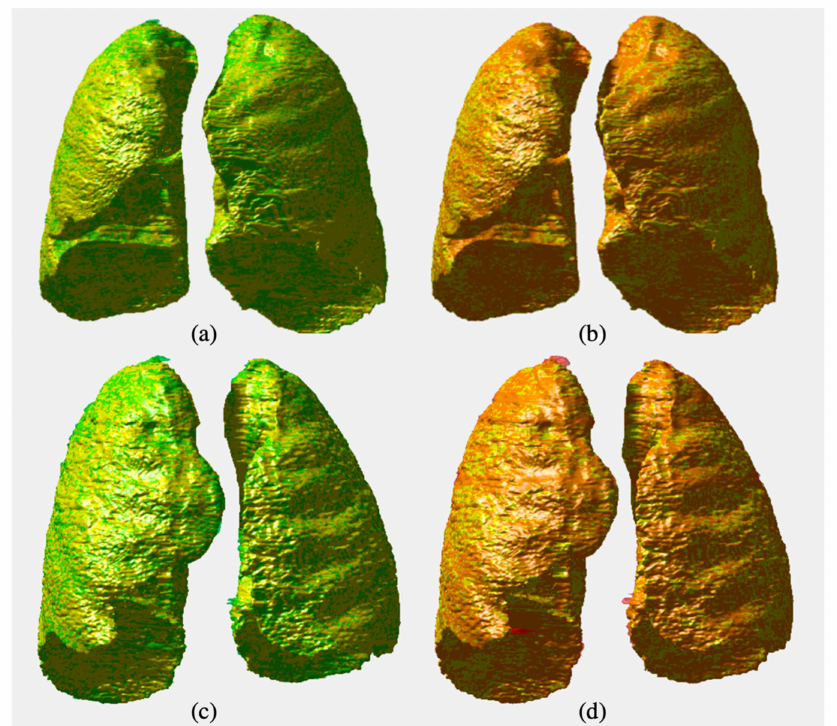
Figure 2. Three-dimensional rendering of two parenchyma delineations. The manual segmentation (yellow), U-Net (green, ( a , c )), and E-Net (red, ( b , d )) are